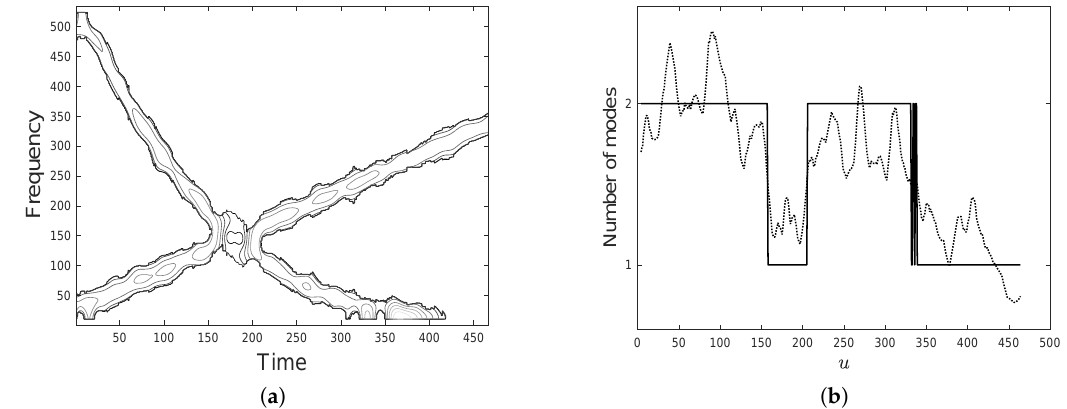
Figure 14. ( a ) Thresholded spectrogram in Figure 11b by using the optimal values in Figure 11c. ( b ) Estimated number of modes by applying the Rényi entropy-based method to ( a ). Local Rényi entropy (dotted line) and its rounded value (solid